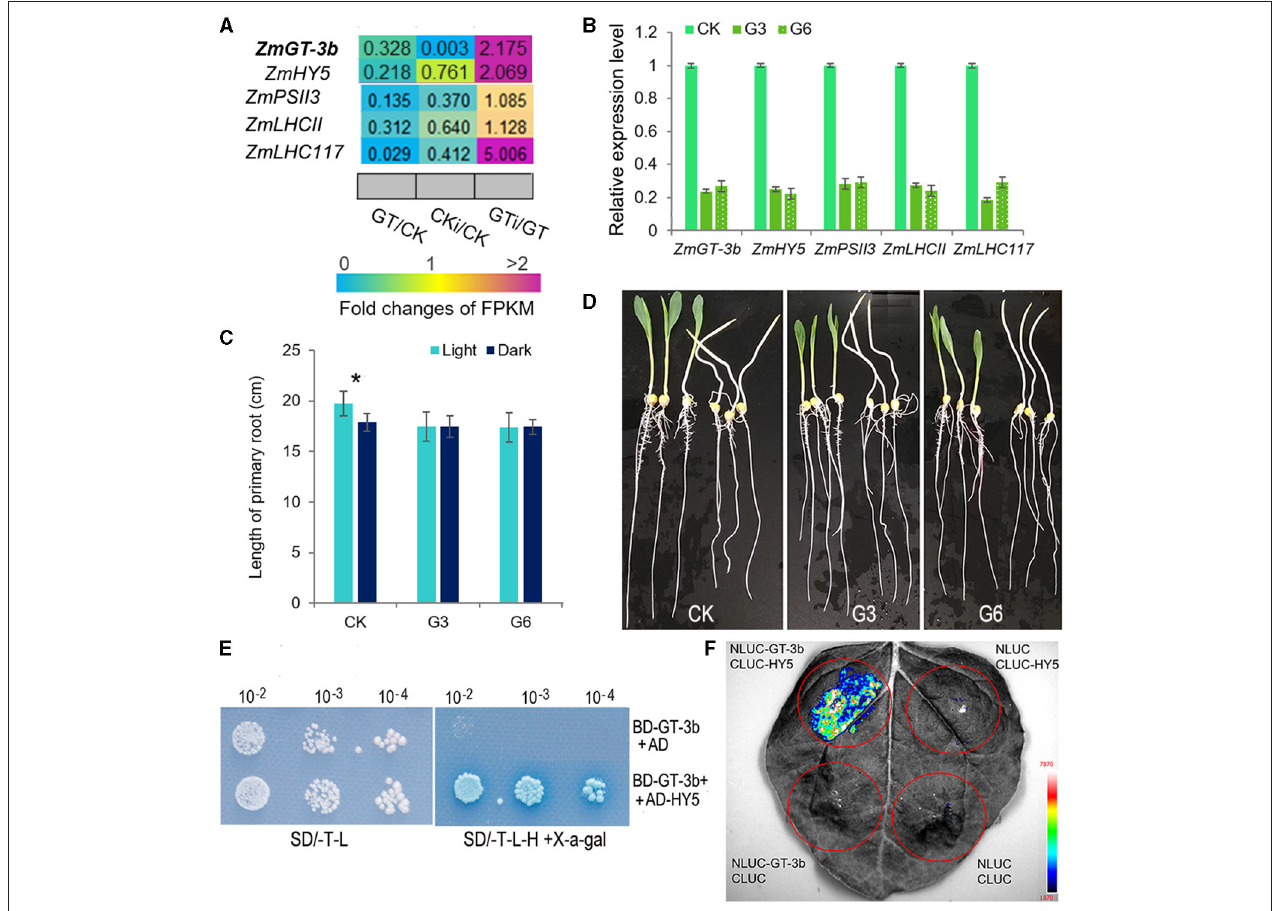
FIGURE 6 | ZmGT-3b may interact with ZmHY5 to regulate photosynthesis and light-related growth. (A) Relative expression (fold) of photosynthesis-related genes from ZmGT-3b knockdown (GT) and CK (LH244) maize seedlings at 7 DAG with (CKi and GTi) or without inoculation (CK and GT) based on transcriptome sequencing. (B) The expression of light-responsive genes, such as ZmGT-3b, ZmHY5, ZmPSII3, ZmLHCII , and ZmLHC117 , was significantly decreased in GT-KD seedlings, as confirmed by quantitative reverse-transcription PCR (qRT-PCR). CK represents control seedlings (LH244), G3 and G6 represent seedlings from the different transgenic events with the knocked-down expression of ZmGT-3b . All seedlings were grown under normal conditions and sampled at 7 DAG. (C,D) GT-KD seedlings with a significant reduction in ZmHY5 expression caused by ZmGT-3b knockdown showed a disrupted shoot illumination-promoted root growth. The average primary root length of CK seedlings grown in the light was significantly higher than that of plants grown in the dark, whereas the average primary root lengths of GT-KD seedlings (G3 and G6) were similar in both the light and dark at 7 DAG (C,D) . Values are the mean ± SD ( n > 15 individual seedlings). The asterisk * represents a significant difference at p < 0.05 (according to the paired Student’s t -test). ZmGT-3b could interact with ZmHY5 in yeast (E) in planta (F) . (E) The AH109 yeast cells transformed with both BD-GT-3b and AD-HY5 could grow well on the medium without Trp, Leu, and His and turn the transformed yeast cell into blue, while the cells containing the BD-GT-3b and AD construct could not grow. (F) Luciferase complementation image (LCI) assay showed that fluorescence signal could be observed in N. benthamiana leaf tissues infiltrated with a combination of Agrobacterium cells that produce NLUC-GT-3b and CLUC-HY5. The combination of NLUC-GT-3b and CLUC, NLUC and CLUC-HY5, NLUC, and CLUC were used as negative